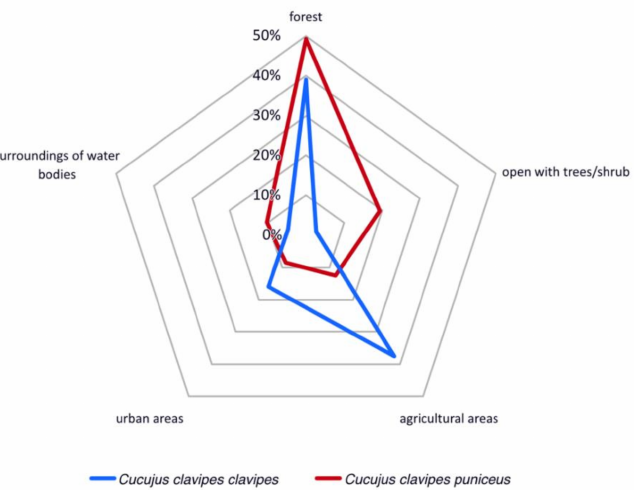
Figure 5. Macrohabitat preferences of Cucujus clavipes subspecies based on citizen scientific data.